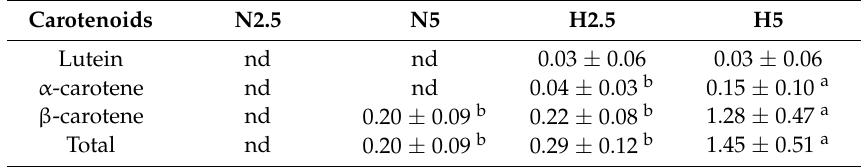
Table 4. Carotenoids content ( µ g/g) in the liver of rats of four experimental groups, at the end of the 5-week intervention period 1 .